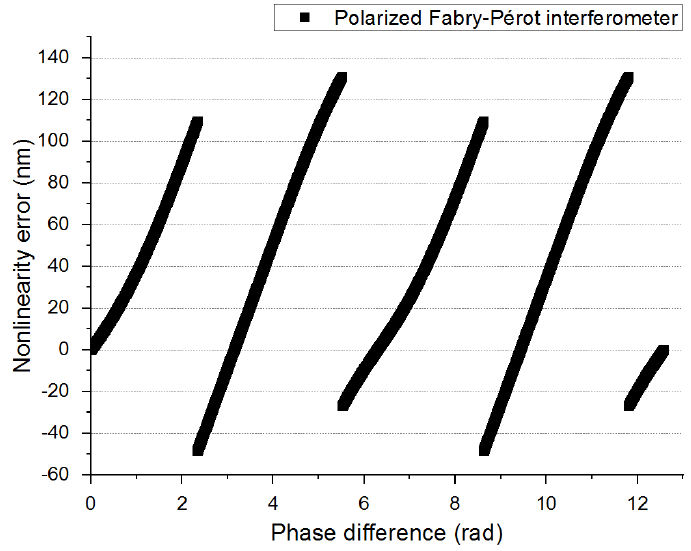
Figure 4. Nonlinearity error of polarized Fabry–Pérot interferometer.